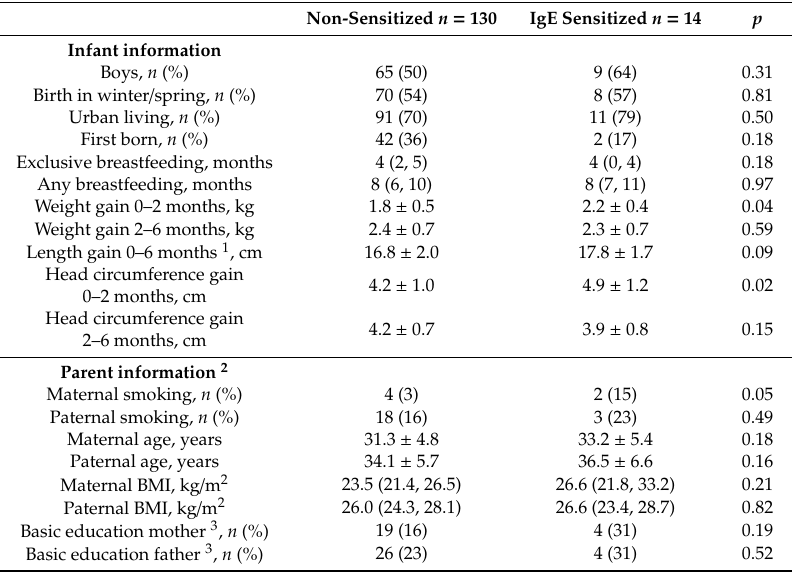
Table 1. Characteristics of the participants included in the study ( n = 144).